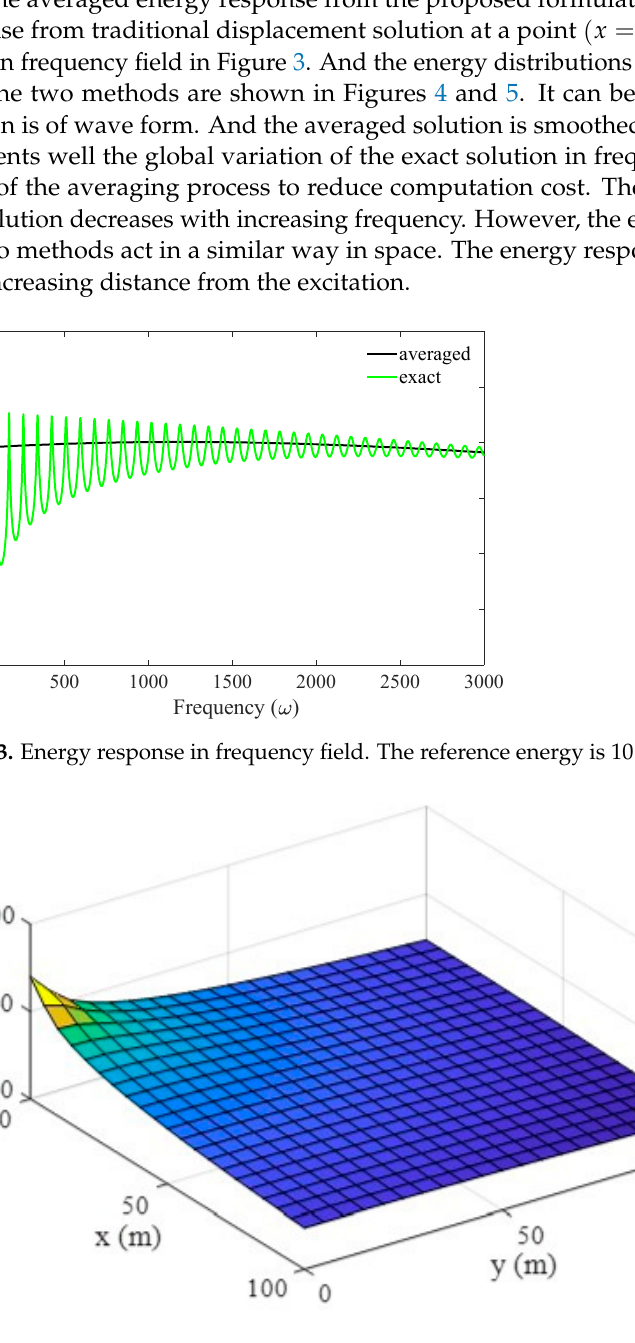
Figure 4. Energy responses in space field from the presented method. The reference energy is 10 − 12 J/m 2